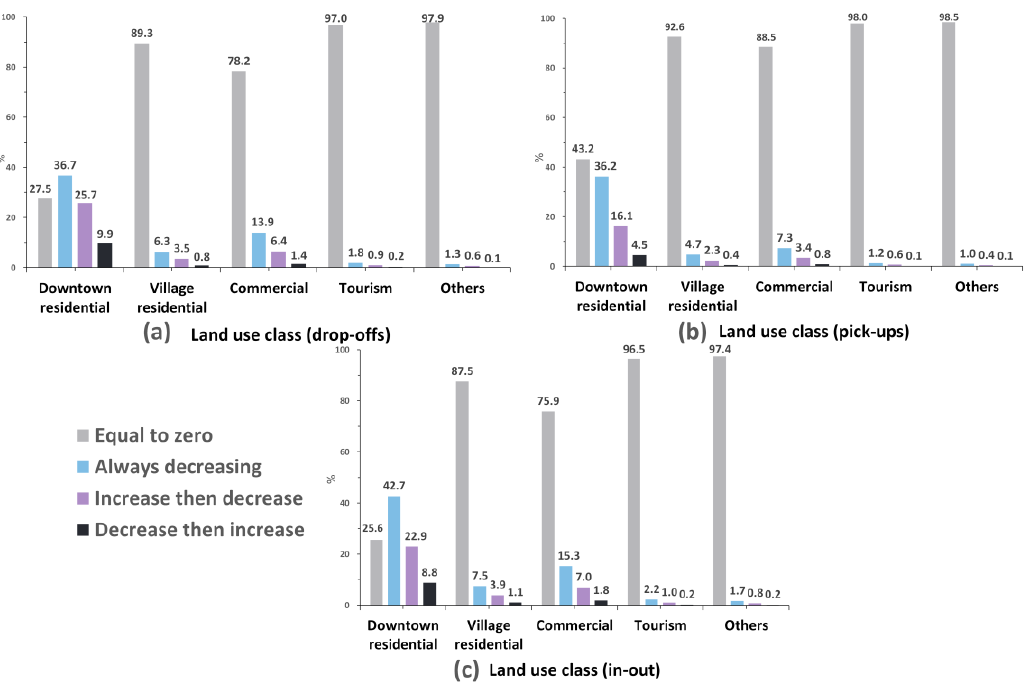
Figure 7. Proportions of crowd flows’ change types in various land use geogrids based on the three taxis flows, ( a – c ) display the flow clustering results of three geogrid base flows (drop-off/pick-up/in- out flow of crowds).